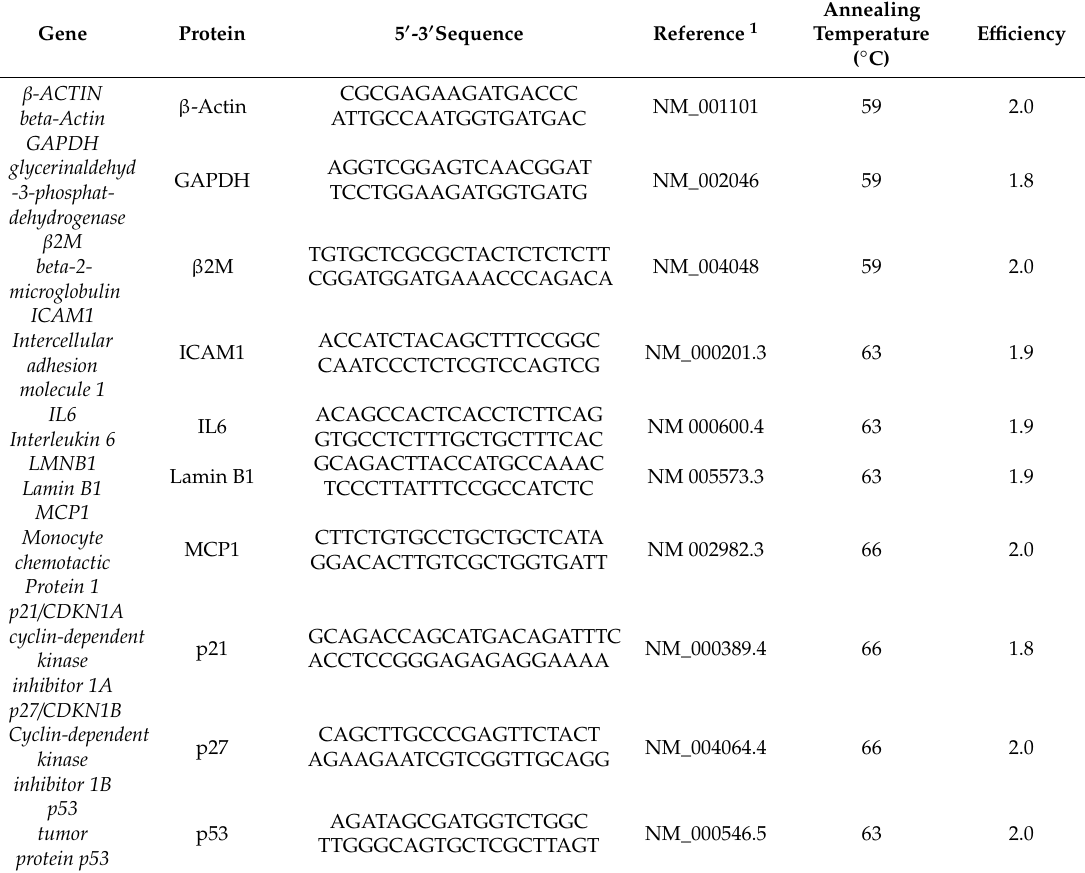
Table 3. Primer sequences used for quantitative real-time